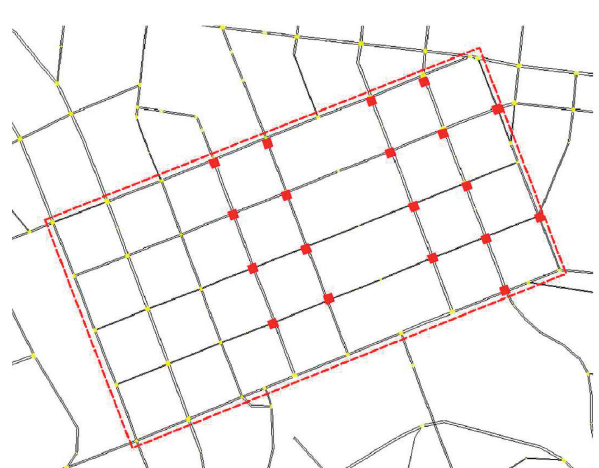
Figure 11: Melbourne CBD subnetwork. The red boundary shows the extent of the area considered in traffic signal optimization problem with red points representing the selected 19 traffic